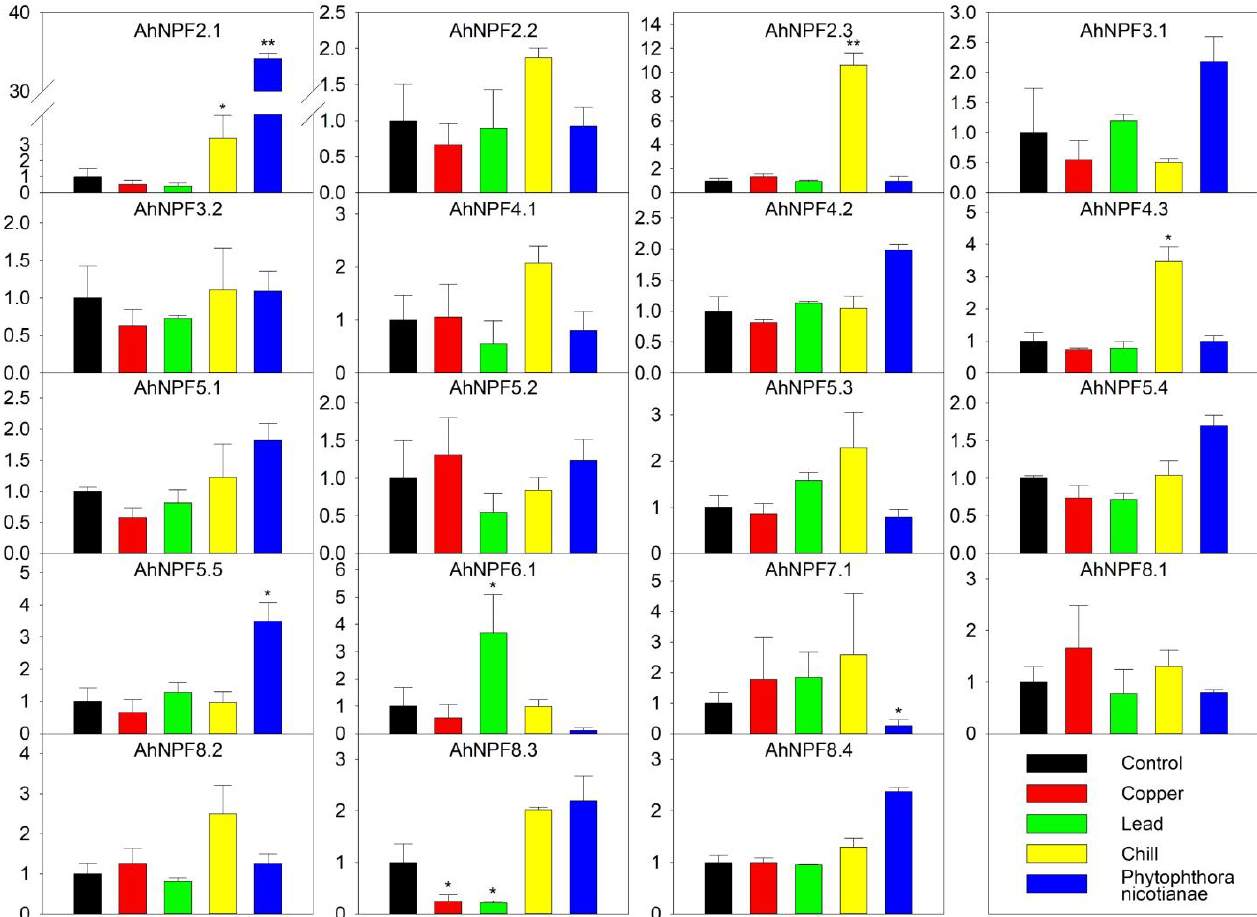
Figure 5. Expression pattern of agave NPF genes under abiotic/biotic stresses by qRT-PCR. Y-axis represents relative expression level. The labels of x-axis represent control, CuSO 4 treatment, Pb(NO 3 ) 2 treatment, chill treatment and Phytophthora nicotianae Breda inoculation, respectively. The error bar represents the standard error. * and ** represent that expression level was increased or decreased by more than 3-fold and 10-fold compared with control, respectively. The expression values of control were normalized as 1.